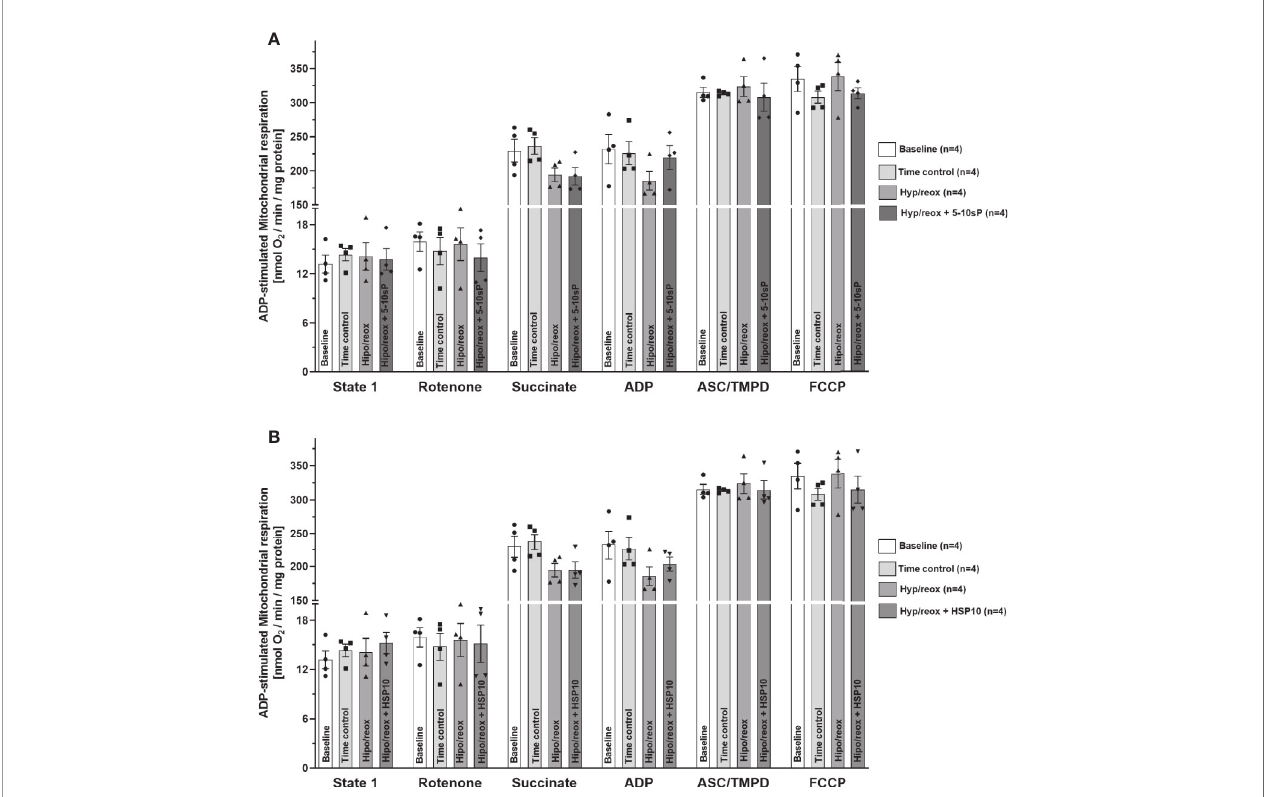
FIGURE 4 | Succinate and adenosine diphosphate (ADP)-stimulated complex II respiration of isolated mitochondria from rat hearts. (A) Hypoxia/reoxygenation plus 5 – 10-sP and (B) hypoxia/reoxygenation plus HSP10. State 1 — without substrates. Rotenone — Rotenone 1 µmol·L − 1 was added to the respiration buffer after 1 min. Succinate — Succinate 5 mmol·L − 1 was added to the respiration buffer after 2 min. ADP — ADP 1 mmol·L − 1 was added to the respiration buffer after 2 min. TMPD plus ascorbate — TMPD 300 m mol·L − 1 plus ascorbate 3 m mol·L − 1 were added to the respiration buffer after 3 min. FCCP — FCCP 30 nmol·L − 1 was added to the respiration buffer after 1 min. Groups: Baseline, Time control, Hypoxia/reoxygenation (Hyp/reox), Hypoxia/reoxygenation plus HSP10 (Hyp/reox+HSP10), Hypoxia/ reoxygenation plus 5 – 10-sP (Hyp/reox + 5 –